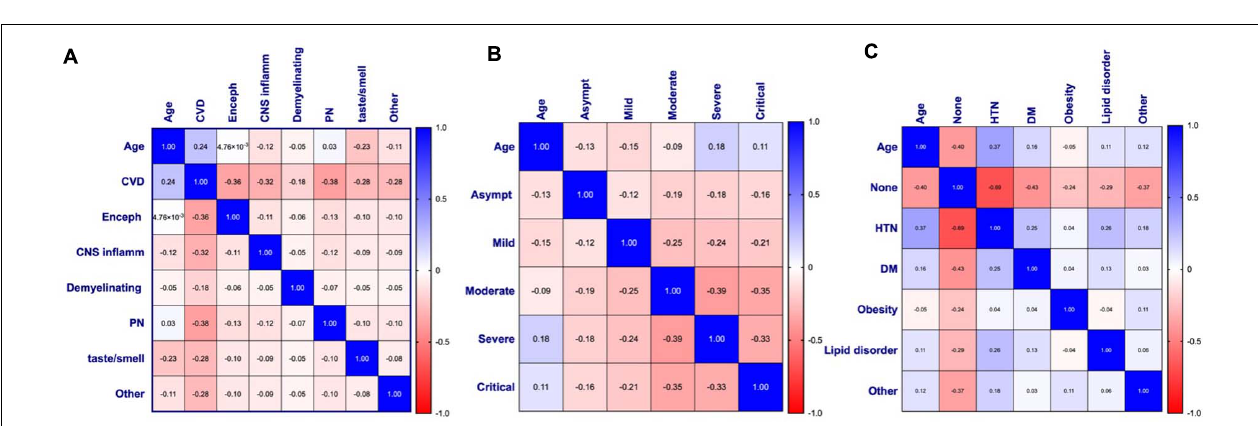
FIGURE 6 | Pearson’s correlation matrices and heat maps for (A) age and neurological disease ( n = 510), (B) age and COVID-19 symptom severity ( n = 495), and (C) age and comorbidities ( n = 363) of patients with COVID-19 and diagnosed with a neurological condition(s). Pearson’s correlation coefficients are displayed and assigned color based on the distance from zero, with blue representing positive and red representing negative correlations. CVD, Cerebrovascular disease; Enceph, Encephalopathy; CNS inflamm, Central nervous system inflammatory disease; PN, Peripheral neuropathy; Asympt, Asymptomatic; HTN, Hypertension; DM, Diabetes